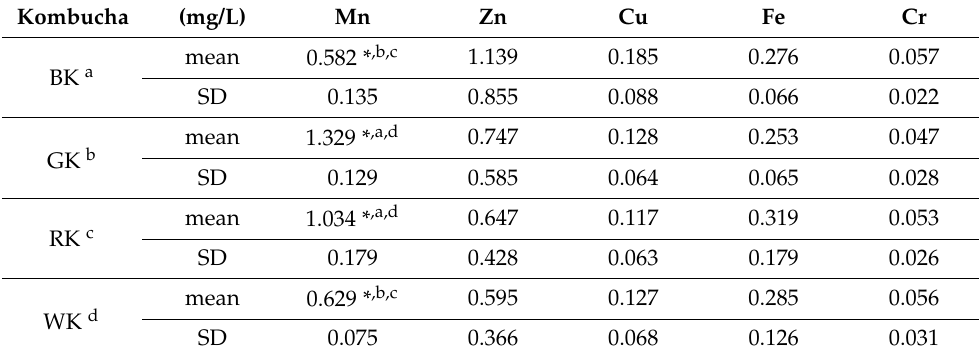
Table 5. The microminerals content in different type of Kombucha. Kombucha